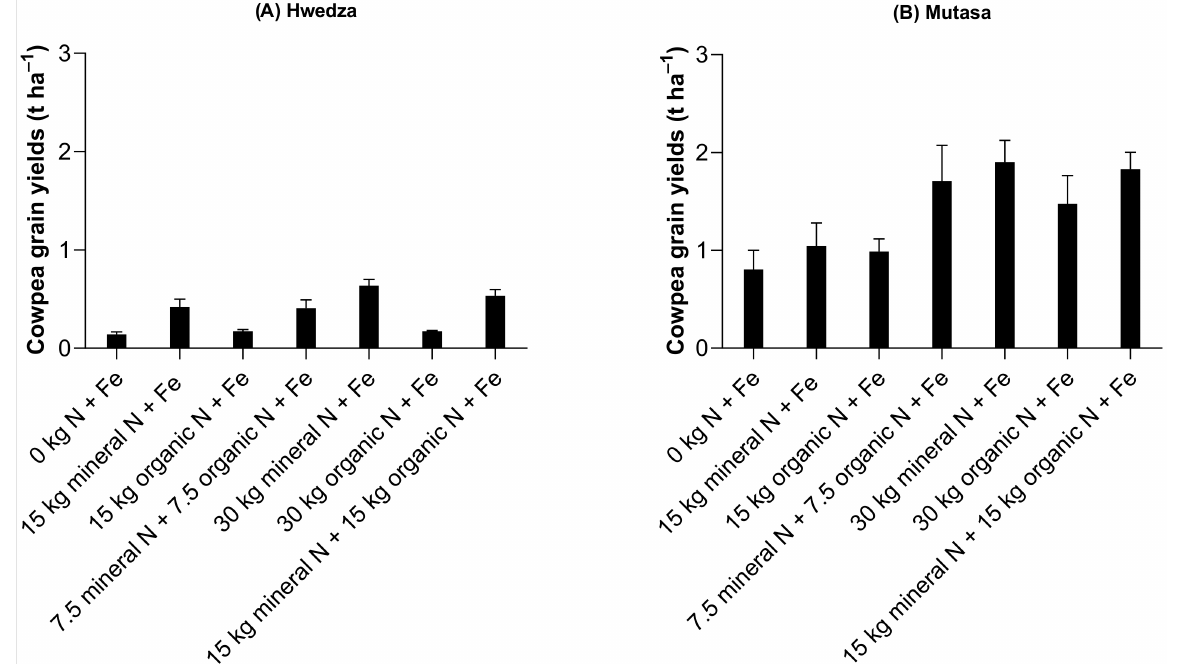
Figure 3. Mean cowpea grain yields ( ± standard error of means, SEM) in ( A ) Hwedza and ( B )